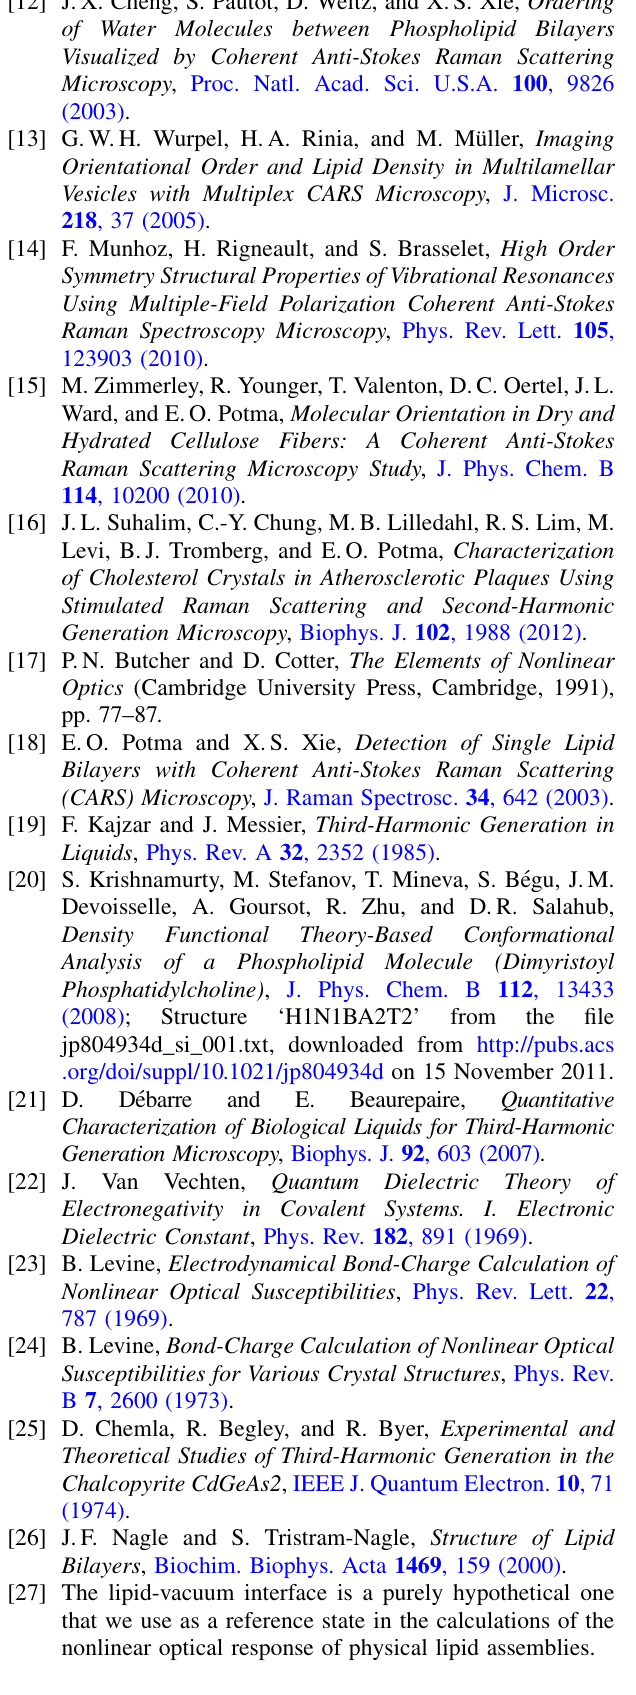
S1, S2, and S3. Movie S1: Multiphoton images of MLVs. The rotating bar (left) indicates the polarization of the exciting fields used to generate the CARS or THG images. Driving fields induce maximal CARS intensity when aligned parallel to the average CH2 moiety and maximal THG intensity when aligned parallel to the average CC bond direction. The P-THG images with polarization-resolved detection illustrate two different THG mechanisms. The THG signal due to birefringence is emitted perpendicular to the excitation field, while the interface signal retains the same polarization direction. Scale bar ¼ 15 (cid:2) m . Movie S2: P-THG imaging of a large multilamellar lipid aggregate. P-THG sensitivity to lipid ordering is clearly visible in this image series of an aggregate of multilamellar objects with varying sizes. THG signals obtained at interfaces and within ordered regions exhibit a strong, easily observed polarization dependence. The rotating bar indicates the excitation polarization and is 50 (cid:2) m in length. Movie S3: P-THG imaging of a human skin biopsy recorded approximately 35 (cid:2) m below the surface. Left: Raw THG images re- corded as the driving polarization is rotated. The rotating bar indicates the polarization incident on the sample. Top right: Modulation image. A strong, order-related modula- tion is observed specifically from the folds containing multilamellar lipid phases, whereas other cellular struc- tures exhibit only weak, geometry-related modulation (see text). Bottom right: Extracted orientation image. The average orientation of lipid molecules in the multilamellar phases is consistently found to be perpendicular to the